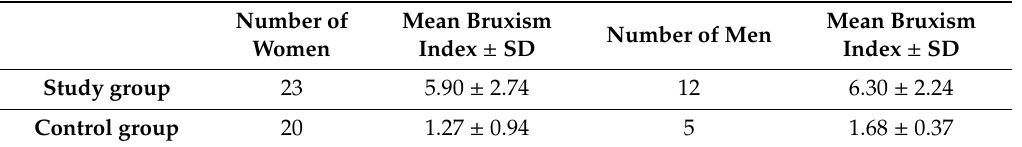
Table 4. Comparison between gender and the average value of the bruxism index in patients from the study and the control